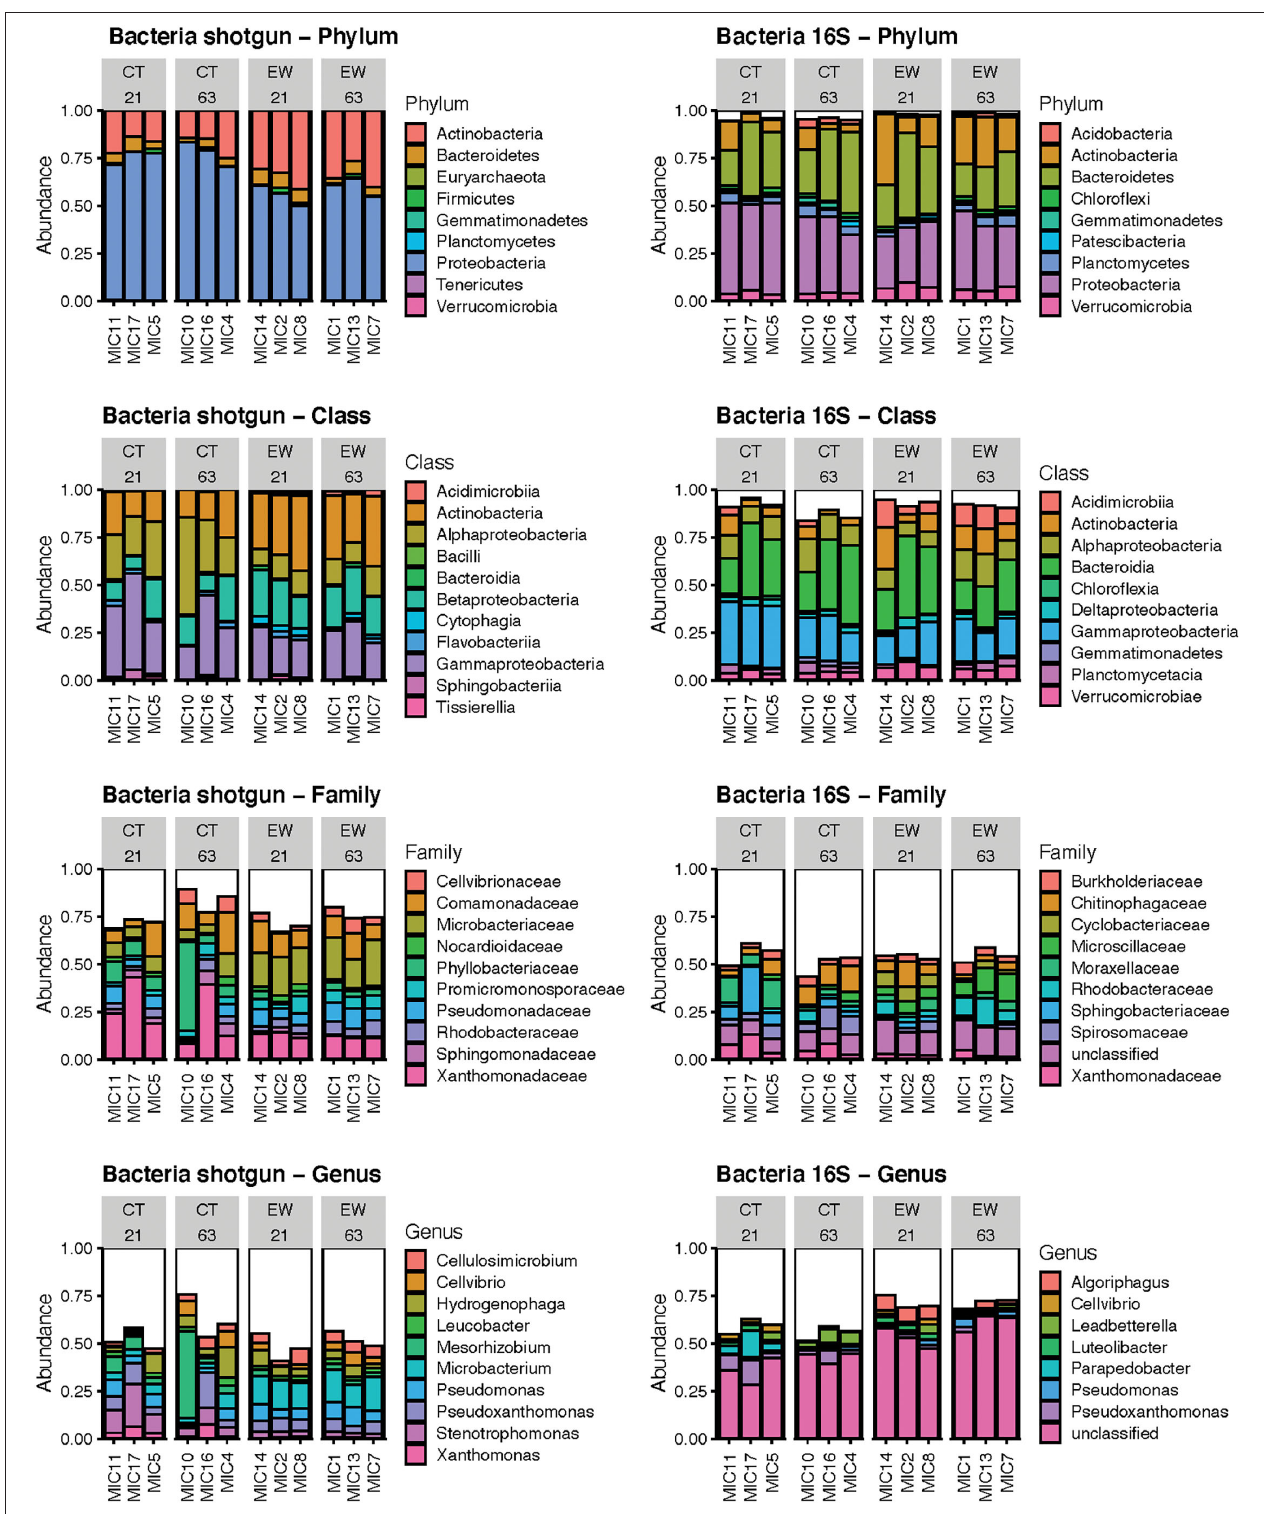
FIGURE 1 | Bar plots of the mean relative abundance of the predominant bacteria by phylum, class, family and genus using shotgun reads and 16S ASVs in 12 microcosms (MIC). The white section of the bar plots represents the less abundant taxa aggregated.